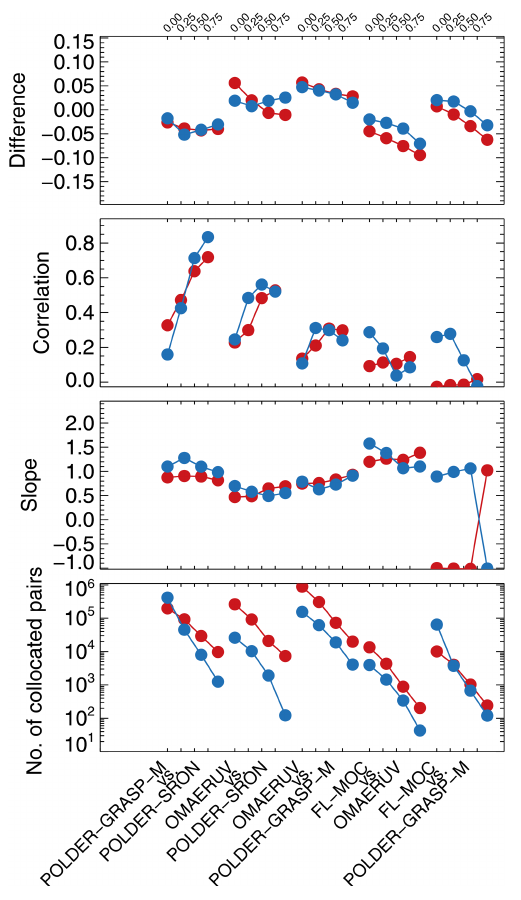
Figure 12. Comparison of different pairs of satellite SSA, over land (red) and ocean (blue), for different thresholds of minimum AOD (0.0, 0.25, 0.5, and 0.75). The data were collocated within 3h.